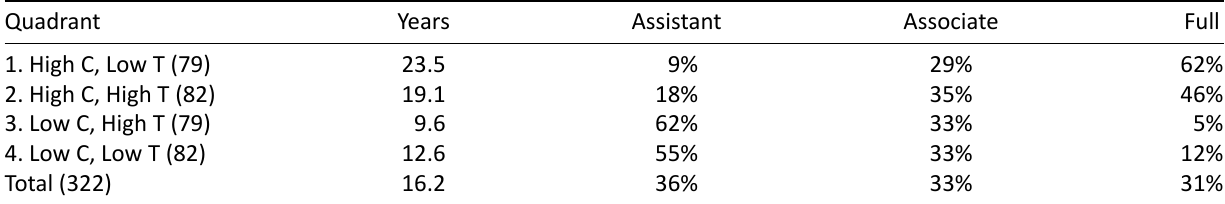
Table 2. Twitter and Citation Levels